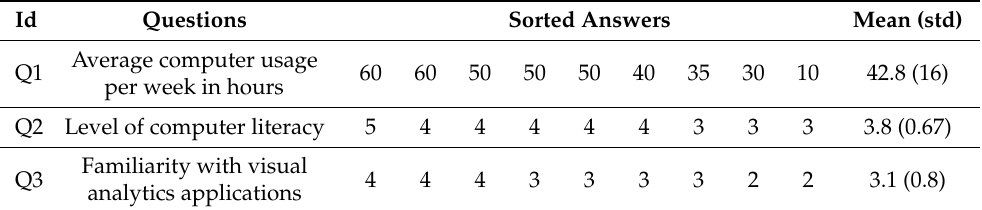
Table 3. Participant’s exposure to digital technologies. Answers are sorted in decreasing